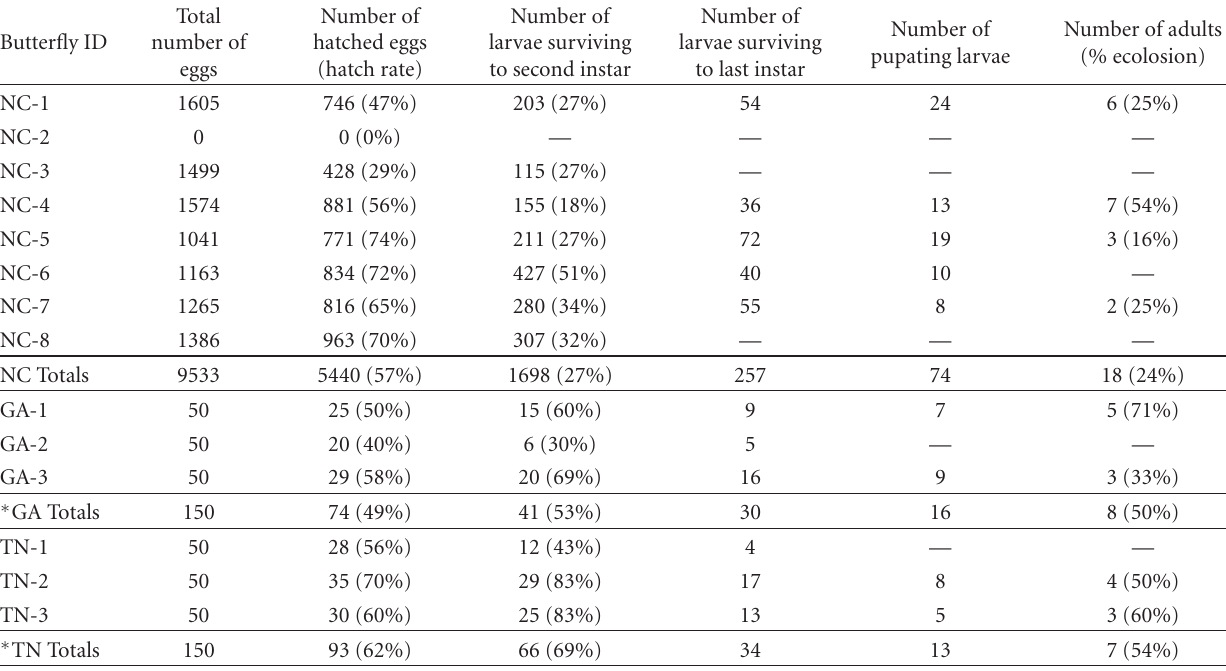
Table 1: Egg production and survival of Argynnis diana females held in captivity for rearing and their progeny.